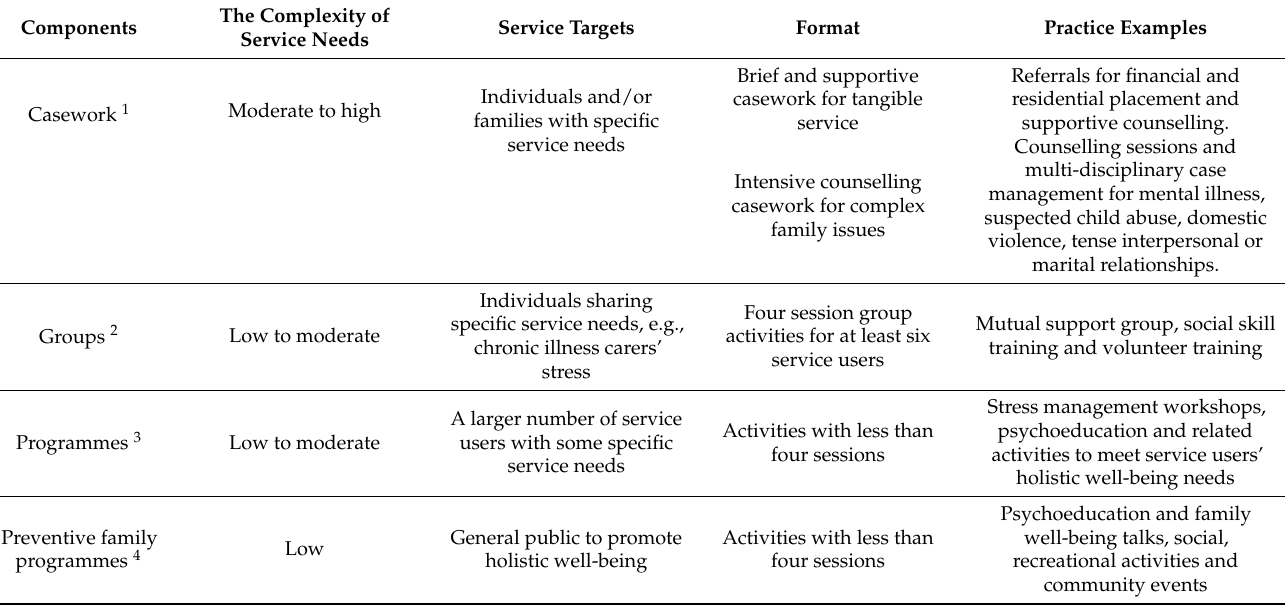
Table 1. The complexity of service needs, service targets, format and examples of four family service